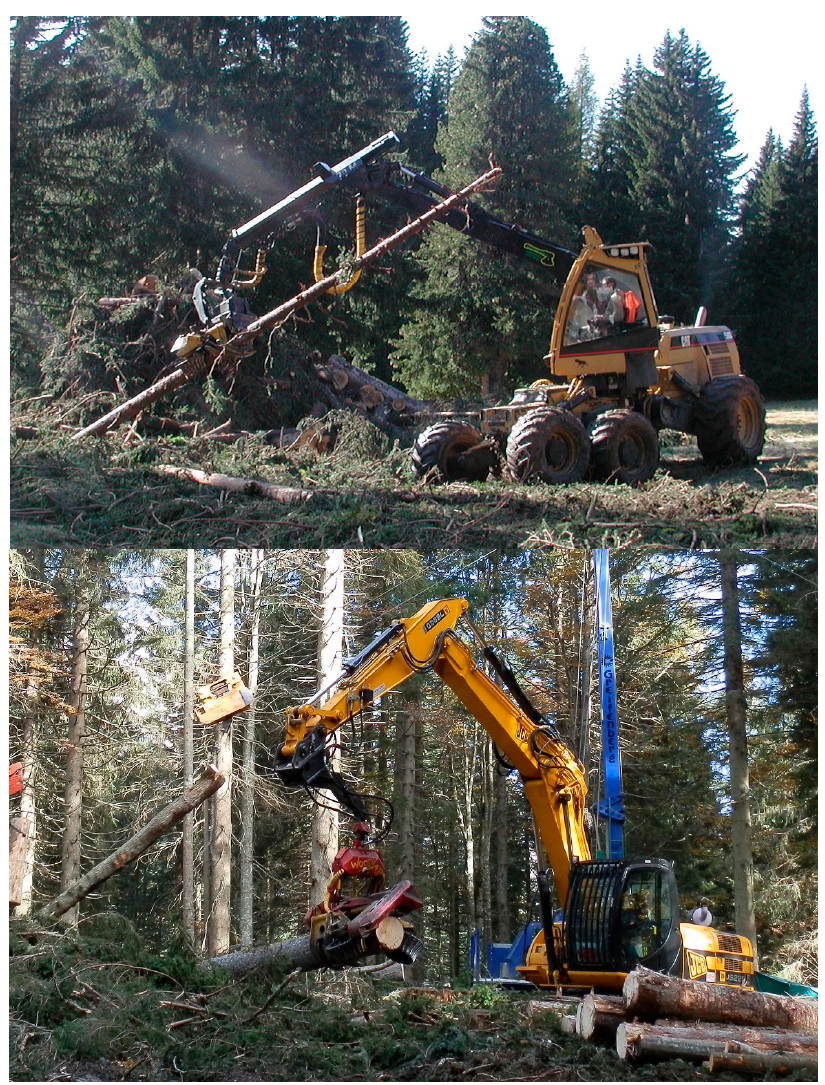
Figure 1. Example of the purpose-built ( top ) and excavator-based ( bottom ) units in the study. These are respectively unit # 2 and # 6.